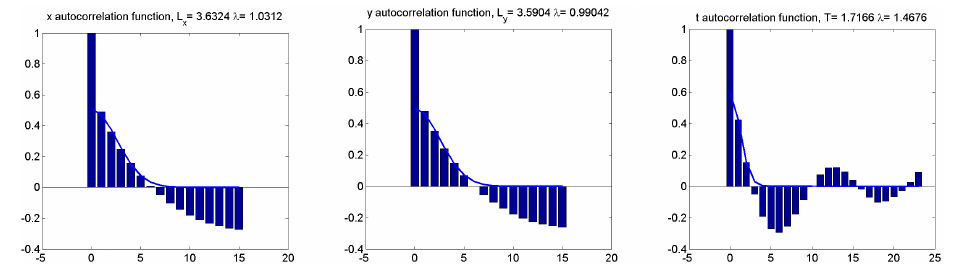
Figure 2. Spectrum analysis leading to autocorrelation functions, for longitude, latitude and time (from left to right). Autocorrelation is given as a function of distance expressed in number of grid points or as a function of time-delay expressed in number of time steps (hours). The continuous line corresponds with the fitted Gaussian correlation function.